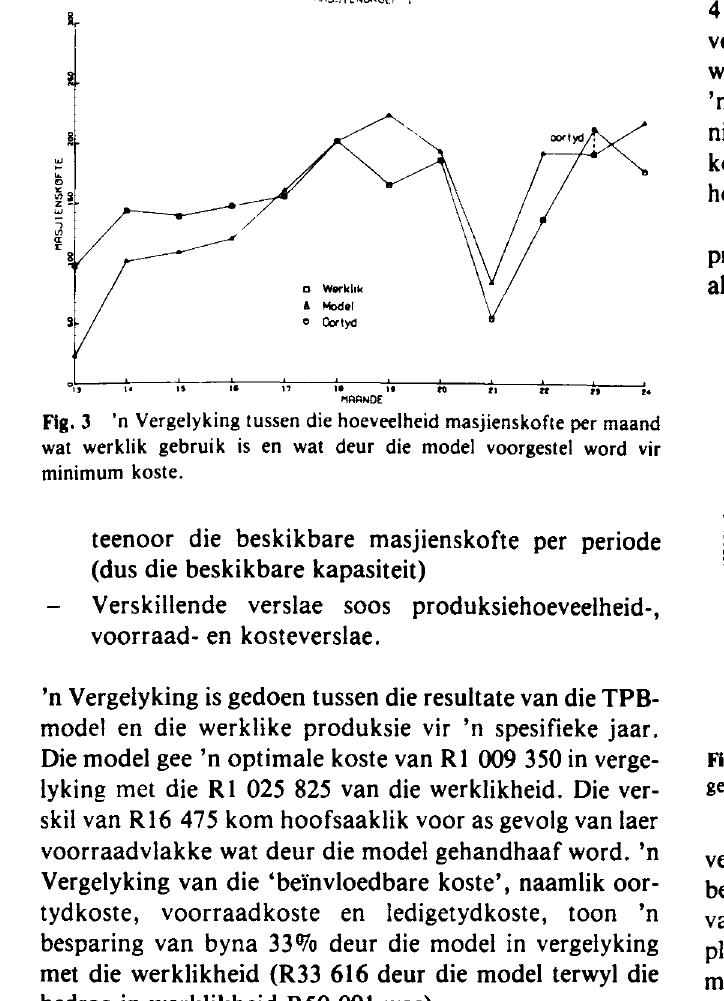
Fig. 3 'n Vergelyking tussen die hoeveelheid masjienskofte per maand wat werklik gebruik is en wat deur die model voorgestel word vir minimum koste.